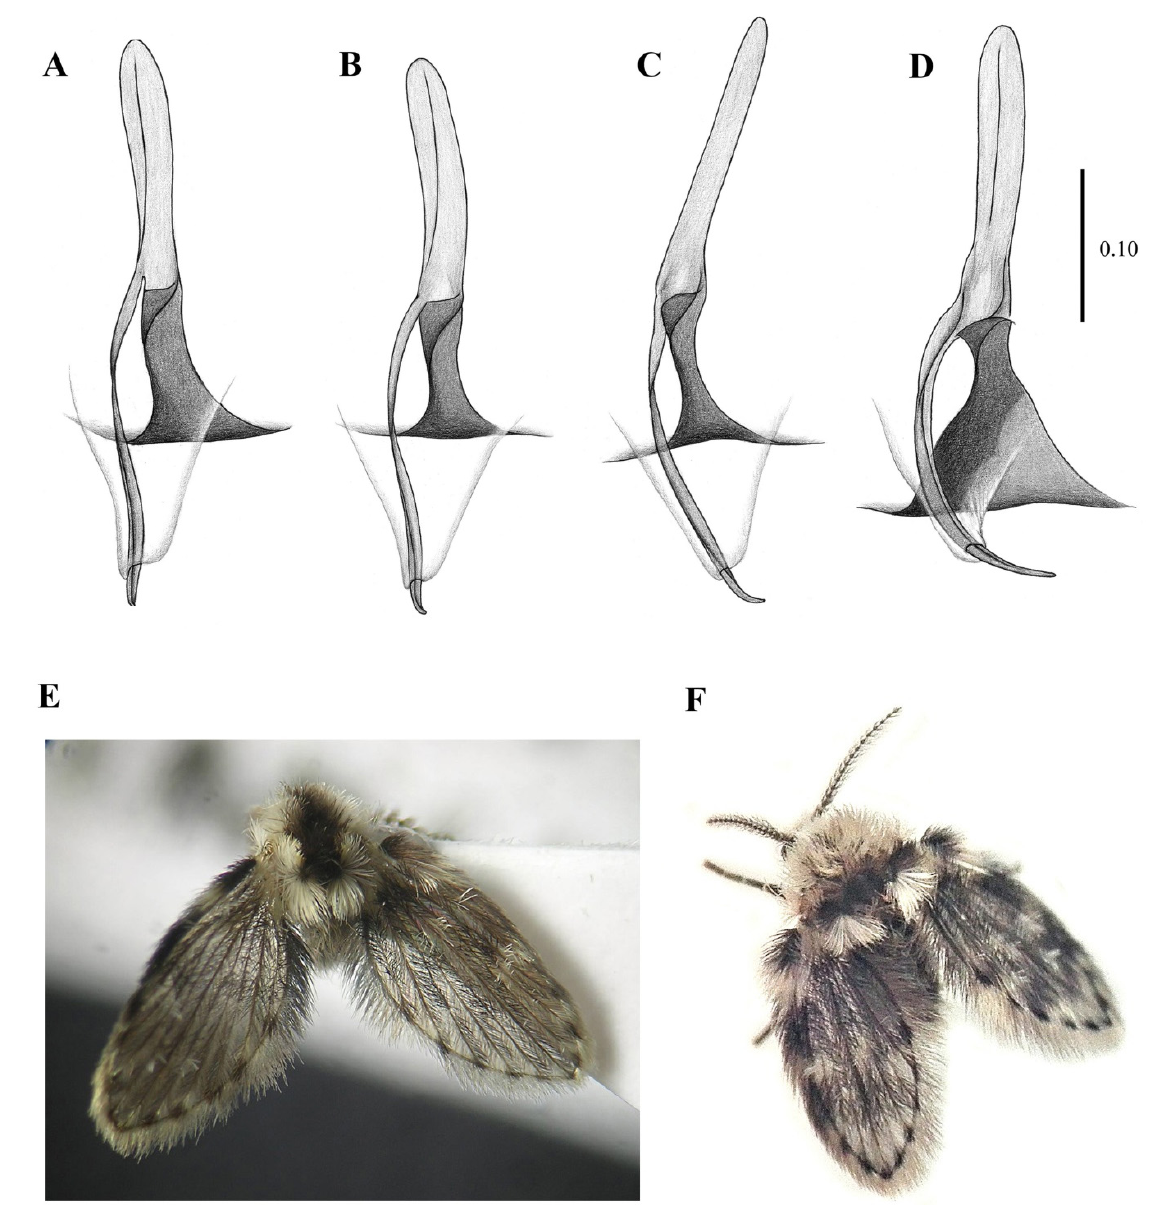
Figure 11. Genitalia variability of Lepiseodina latipennis (Sarà, 1953): ( A – C ) Aedeagal complex in dorsal view. ( D ) same in posterodorsal view. ( E ) Habitus of L. latipennis (Sarà, 1953) , ( F ) Habitus of L. rothschildi (Eaton, 1912) . Scale ( A – D ) in millimeters (mm); without scale ( E , F ).